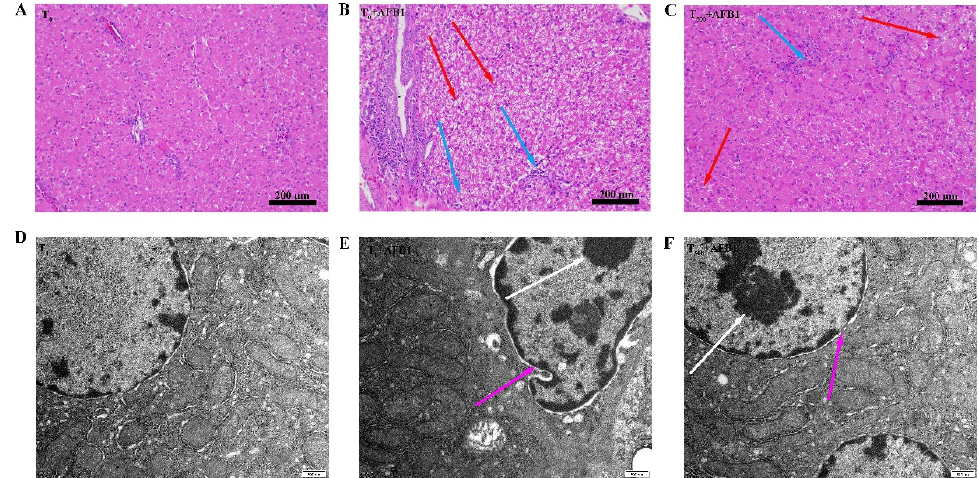
Figure 2. Histopathological and ultrastructure examination in liver of ducks exposed to AFB1 at 12 h. ( A ): control group (T 0 ), ( B ): AFB1 group (T 0 + AFB1); ( C ): curcumin + AFB1 group (T 500 + AFB1); ( D ): control group (T 0 ), ( E ): AFB1 group (T 0 + AFB1); ( F ): curcumin + AFB1 group (T 500 + AFB1). The blue arrowheads indicate swollen of liver cells, the red arrowheads indicate inflammatory cell infiltration, the white arrowheads indicate chromatin aggregation, and the pink arrowheads indicate the morphology of the cell nucleus.